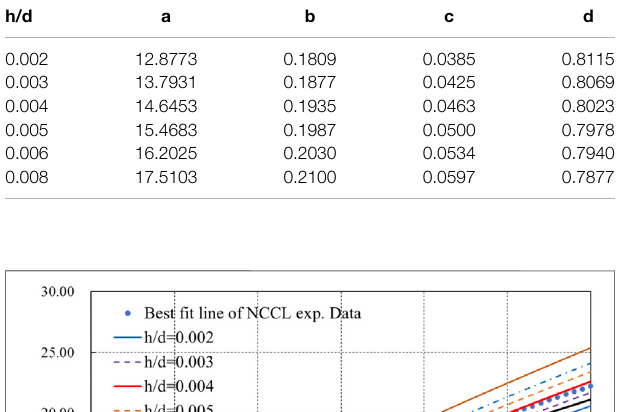
FIGURE 9 | Ratios of the conductive term for different relative roughnesses.